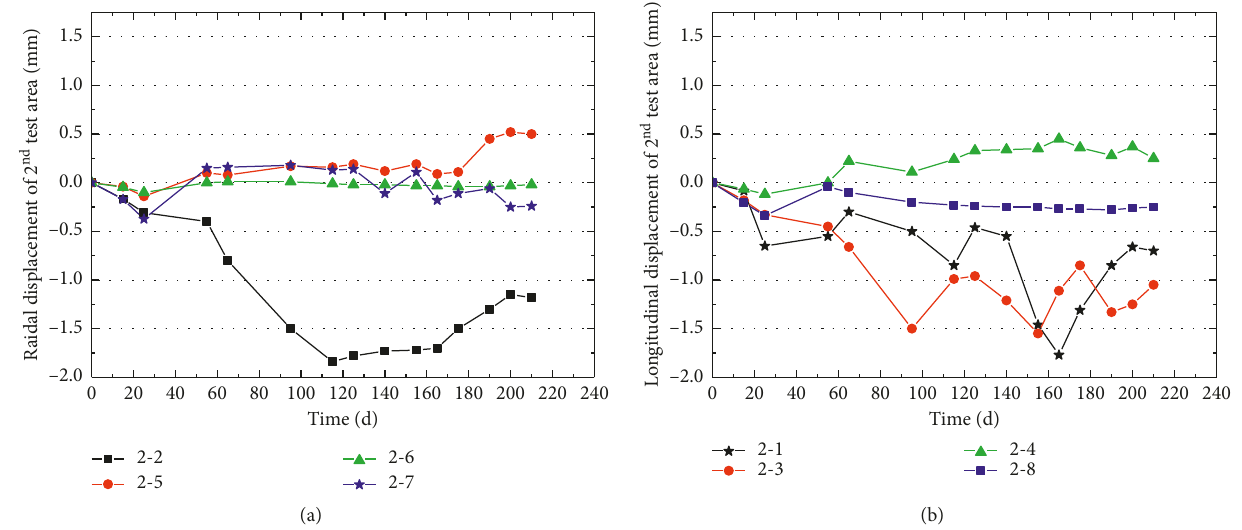
Figure 11: Radial and longitudinal displacement curves at the second test area ( − 430 m). (a) Radial displacement; (b) longitudinal